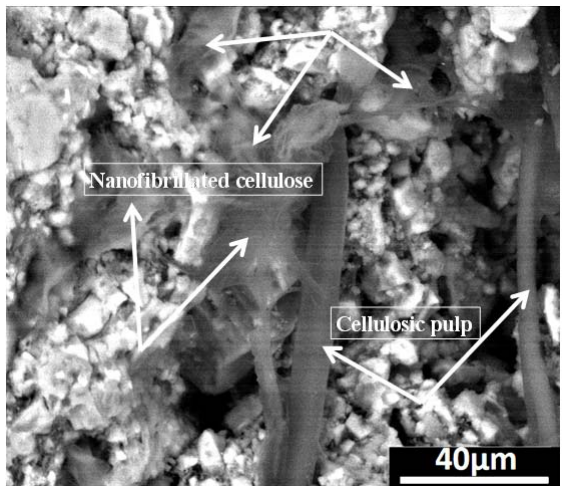
Figure 8. Micrograph of hybrid composite showing the adhesion capacity of nanofibrillated cellulose with the pulp and cement matrix.